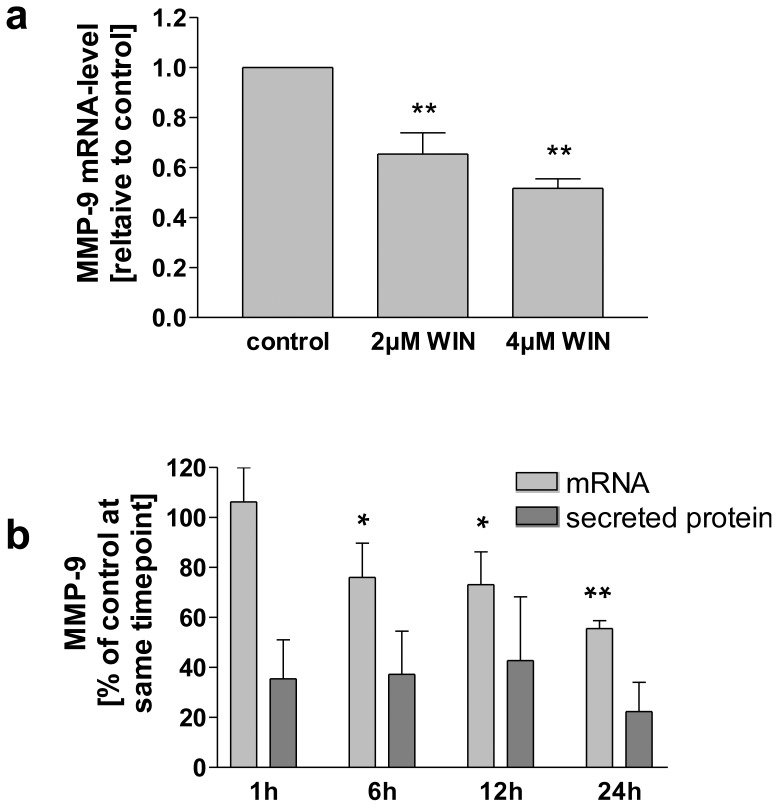
WIN down-regulated MMP-9 mRNA in U937-macrophages.(a) Quantitative real-time PCR of MMP-9 mRNA. 2 µM and 4 µM WIN decreased MMP-9 mRNA to 66% and 55% respectively. Data are shown as means +/− SD n = 3. **p<0.01 vs. control according to Newman-Keuls Multiple Comparison test following ANOVA. (b) Comparison of MMP-9 mRNA and secreted protein, assessed by real-time PCR (n = 3) and densitometry of Western blot analyses (n = 2). Values of mRNA and secreted MMP-9 Protein are given as percentage of the amounts that were measured in untreated cells at the corresponding time point. Secretion of MMP-9 protein was already decreased to 40% after 1 h, and remained in this range for 24 h. In contrast, no mRNA decrease was observed after 1 h, mRNA level decreased steadily to 55% after 24 h. Data are shown as means +/− SD, *p<0.05, **p<0.01 vs. 1 h according to Newman-Keuls Multiple Comparison test following ANOVA.